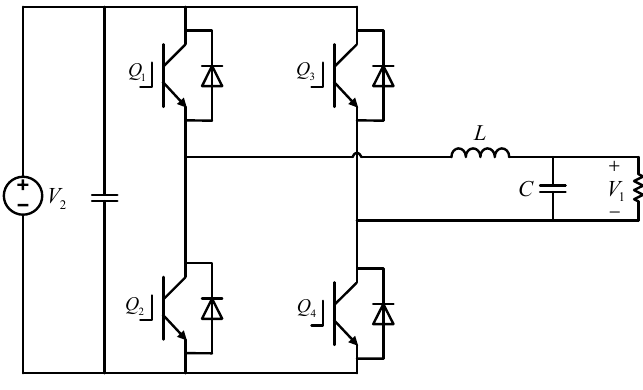
Figure 5. Simplified model of bidirectional DC-DC converter.